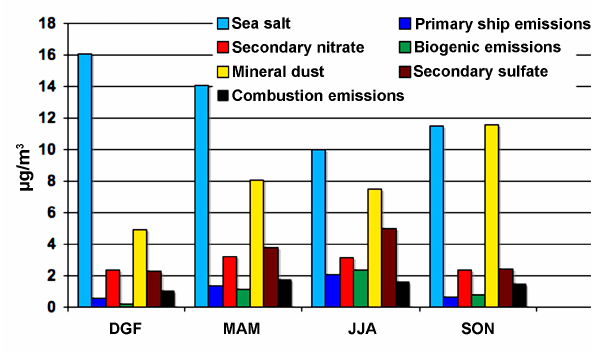
Figure 9. Seasonal absolute contributions to PM 10 concentration (average over the years 2007–2008).